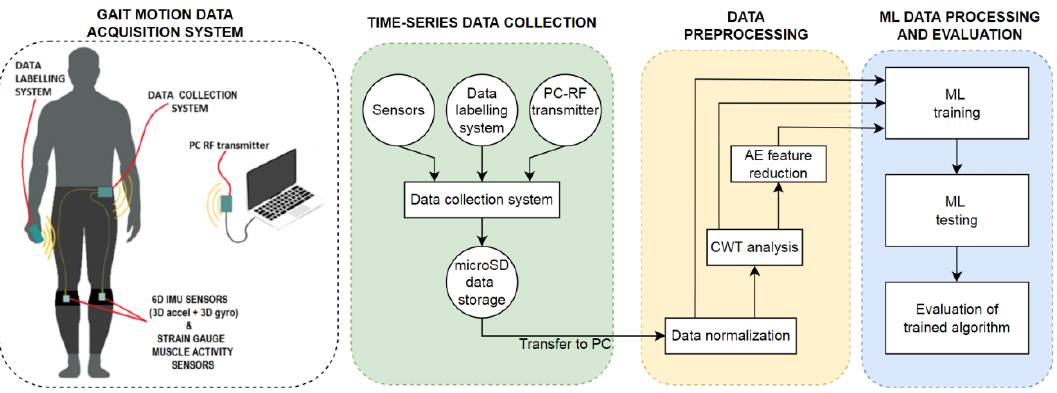
Figure 2. Sketch of the proposed system.